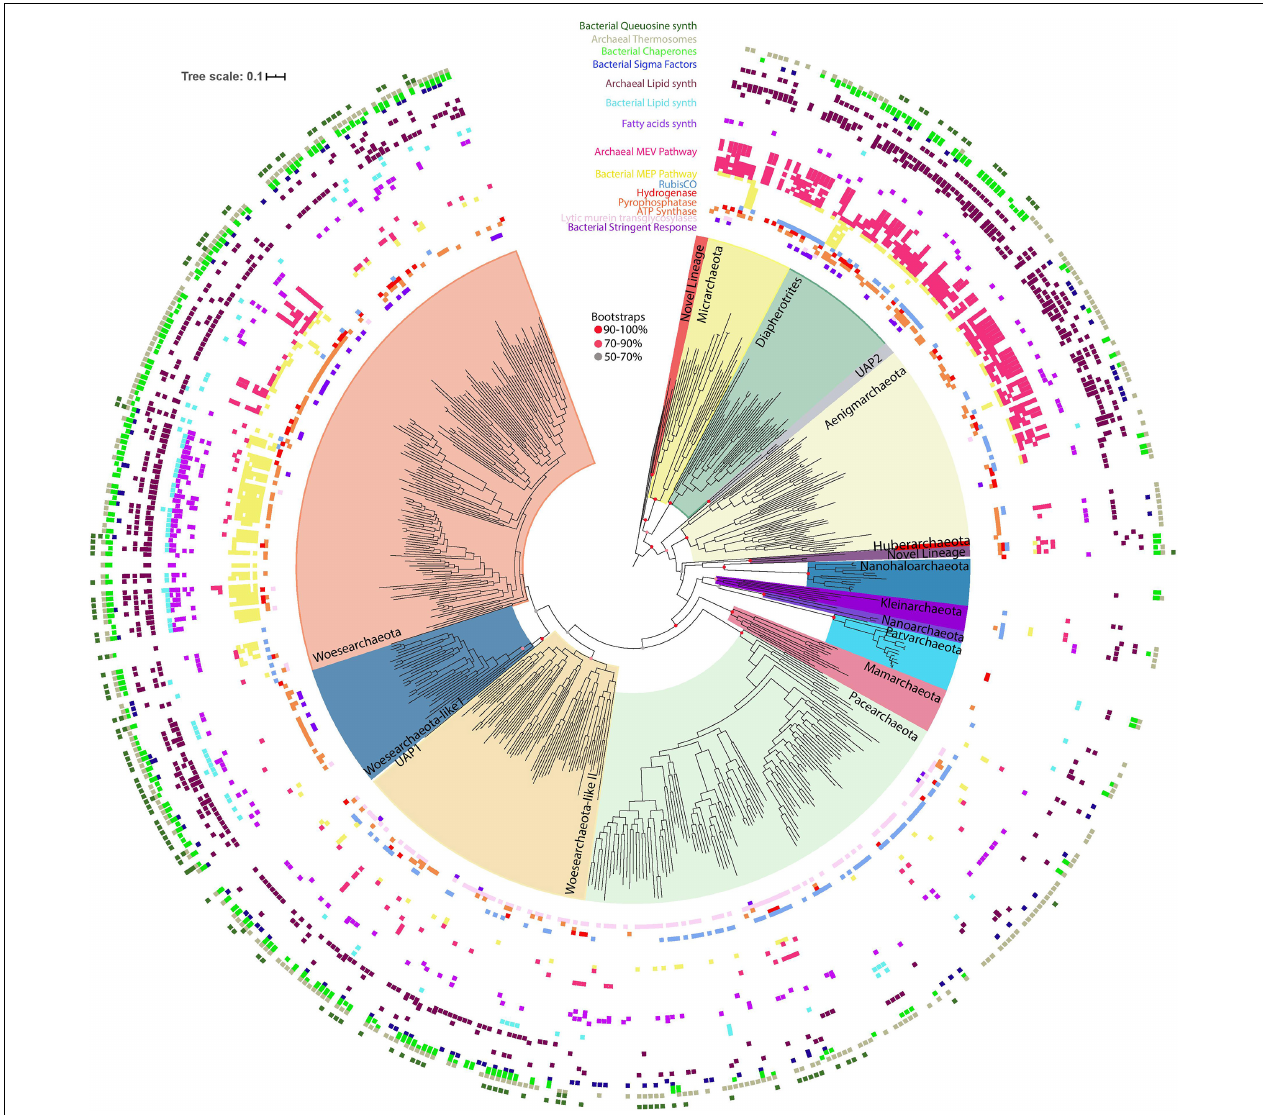
FIGURE 1 | Taxonomic assessment and distribution of the newly DPANN genomes with metabolic similarities and distribution among DPANN lineages. Maximum-likelihood phylogeny of the DPANN lineages using Altiarchaeota as an outgroup and based on a 14-ribosomal-protein concatenated alignment (3,677 amino acids, LG + R10 model). The presence/absence of a subset of targeted metabolic traits is indicated as concentric rings. The scale bar indicates the mean number of substitutions per site. A fully annotated tree with all included lineages, more metabolic features as well as the bootstrap values are available in Supplementary Figure 1